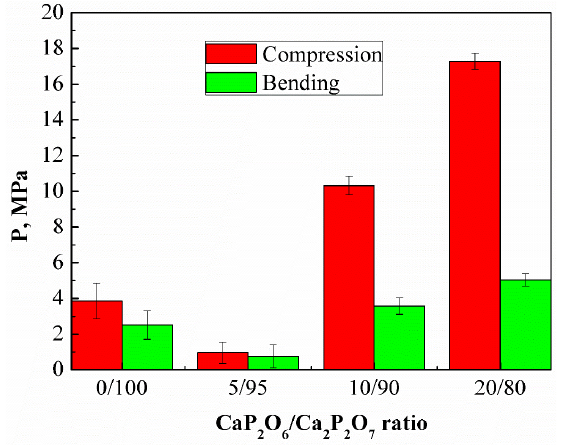
Figure 11. The compressive and bending strengths of the samples with a weight ratio of: Ca(PO 3 ) 2 /Ca 2 P 2 O 7 = 0/100; Ca(PO 3 ) 2 /Ca 2 P 2 O 7 = 5/95; Ca(PO 3 ) 2 /Ca 2 P 2 O 7 = 10/90; Ca(PO 3 ) 2 /Ca 2 P 2 O 7 = 20/80 after annealing at a temperature of 1000